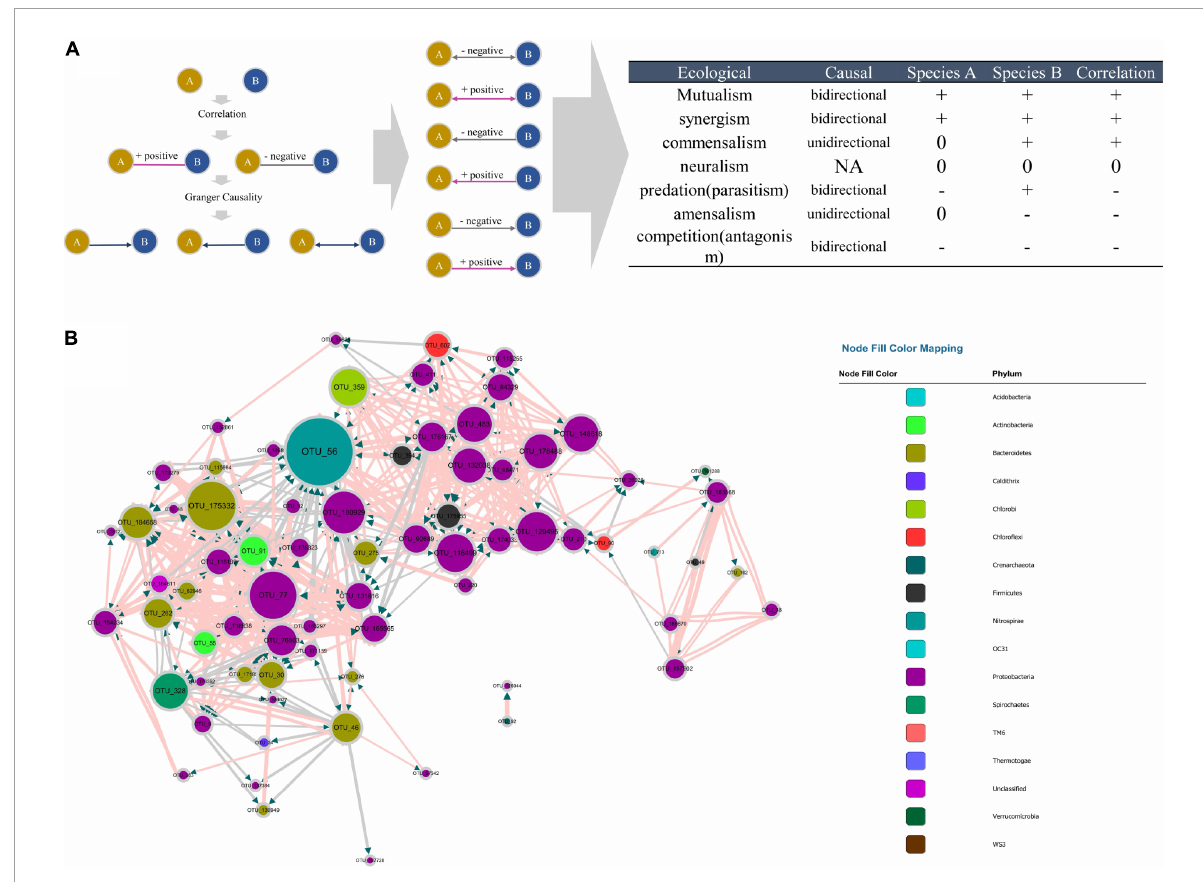
FIGURE4 (A) Principle of the MCCN inference from the combination of causality and correlation, the detail of correspondence from MCCN link to ecological interaction on the right table. (B) MCCN, each color represents an individual phylum. The size of the node and node labels are linearly proportionate to the edge number of each node from 0 to 50. The arrows represent the direction of Granger causality. Pink and gray link colors represent positive and negative associations, respectively. The size of the link is proportionate to the correlation absolute value from 0 to